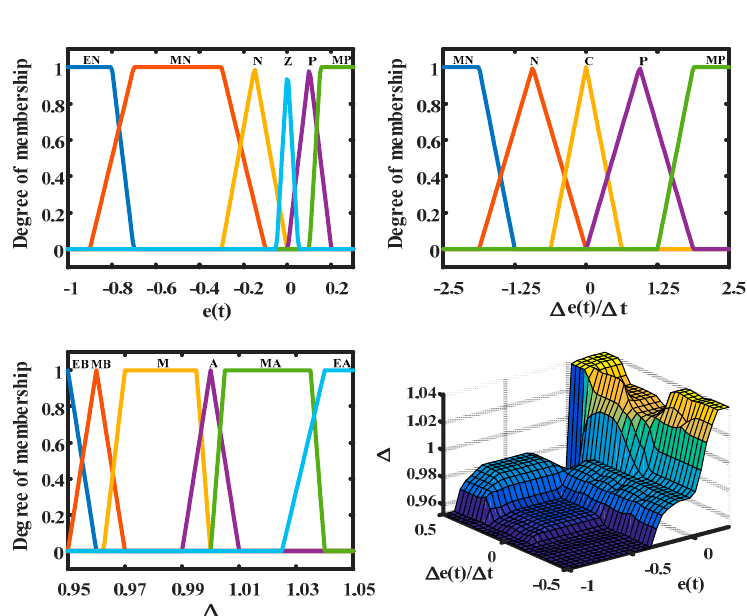
Figure 10. Membership functions for the input and output variables of the regeneration rate